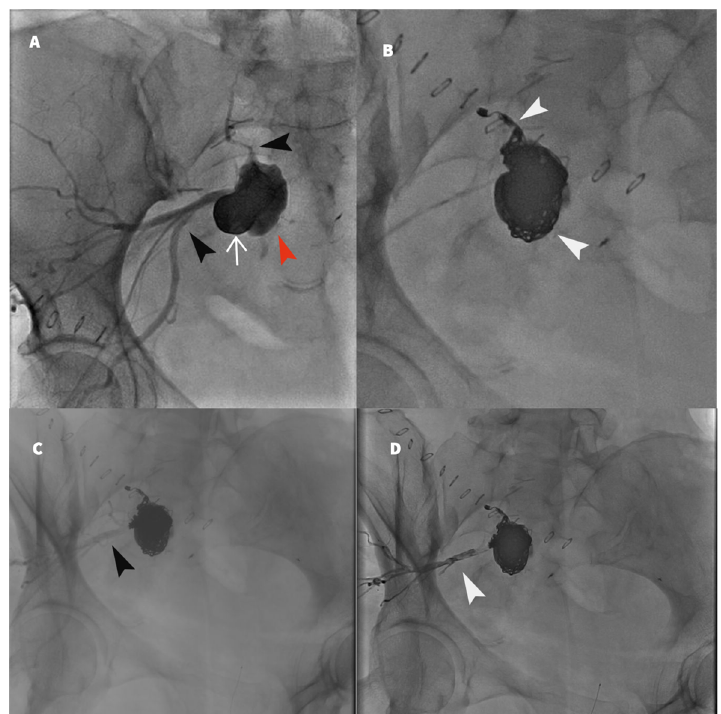
Fig. 4 Pelvic angiogram through superior gluteal artery retrograde access of the left internal iliac artery. A ) Initial angiogram demonstrates prior partial onyx embolization of the mycotic pseudoaneurysm (white arrow). Enlarging mycotic pseudoaneurysm sac (red arrowhead). Feeding vessels (black arrowhead). B ) Coil embolization of the mycotic pseudoaneurysm sac and the inflow lateral sacral artery (white arrowheads). C ) Pelvic angiogram post coil embolization demonstrates the outflow feeding vessels (black arrowhead). D ) Onyx embolization of the outflow vessels (white arrowhead)